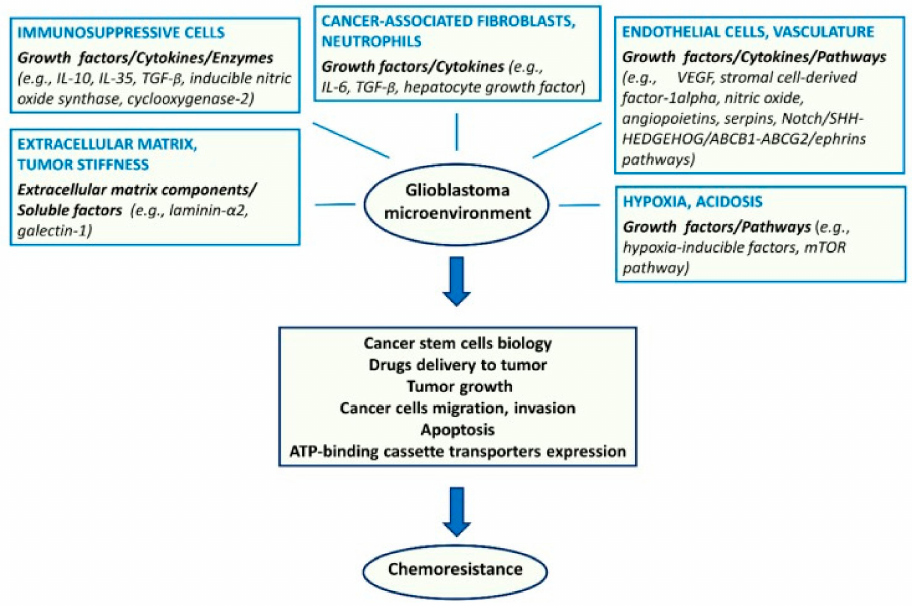
Figure 4. Major components of the tumor microenvironment and key molecular factors and pathways affecting glioma stem cell biology and chemoresistance [96]. License of this figure provided at https://creativecommons.org/licenses/by/4.0/ (accessed on 19 February 2021). Changes made: figure